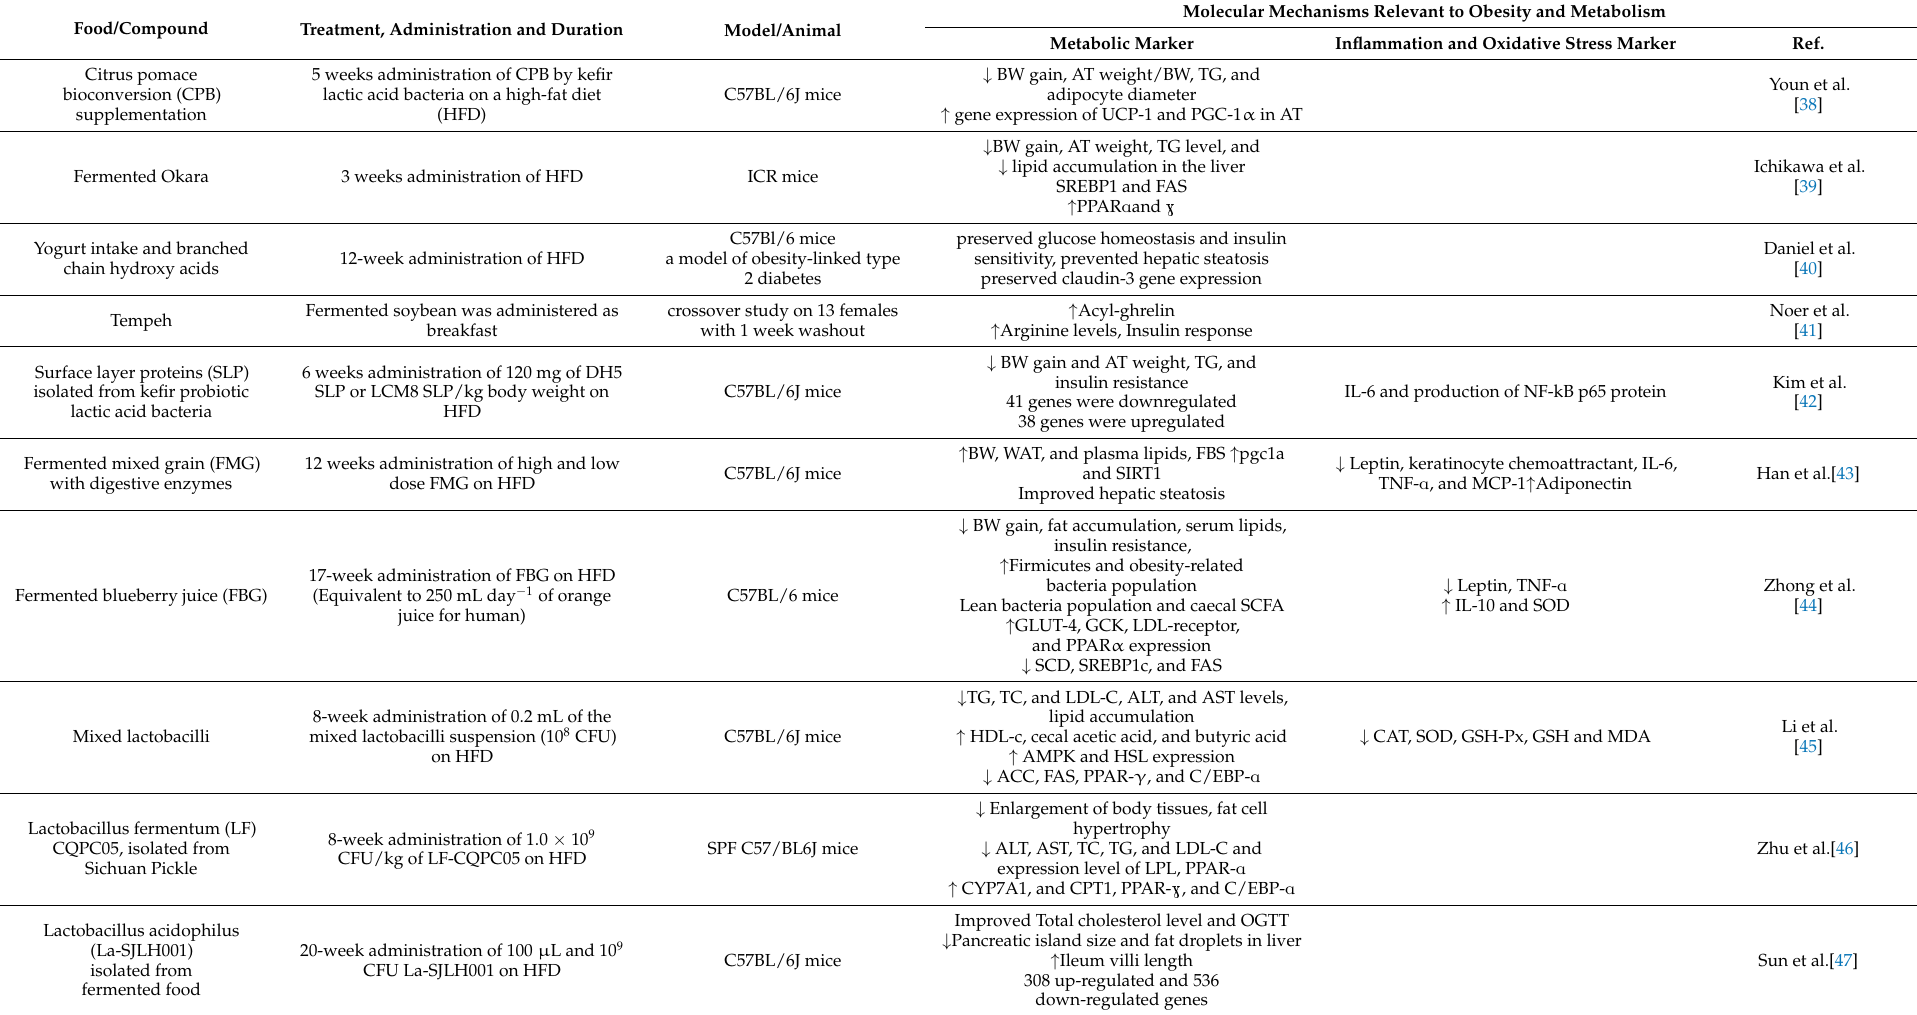
Table 1. Summary of the effects of kefir products on obesity and mechanisms of